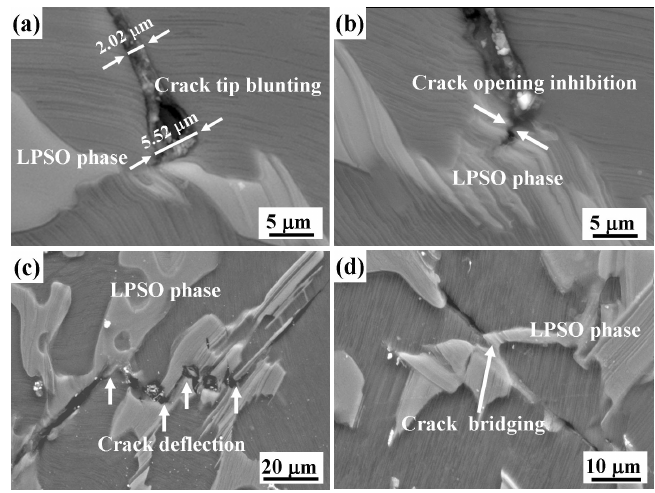
Figure 5. Microstructure of the as-cast Mg 95.5 Y 3 Zn 1.5 alloy after dynamic deformation at the strain rate of ~3000 s − 1 , showing the relationships between the cracks and LPSO phase: ( a ) Crack tip blunting (the white arrows indicated crack opening displacement); ( b ) Crack opening inhibition; ( c ) Crack deflection; ( d ) Crack bridging.